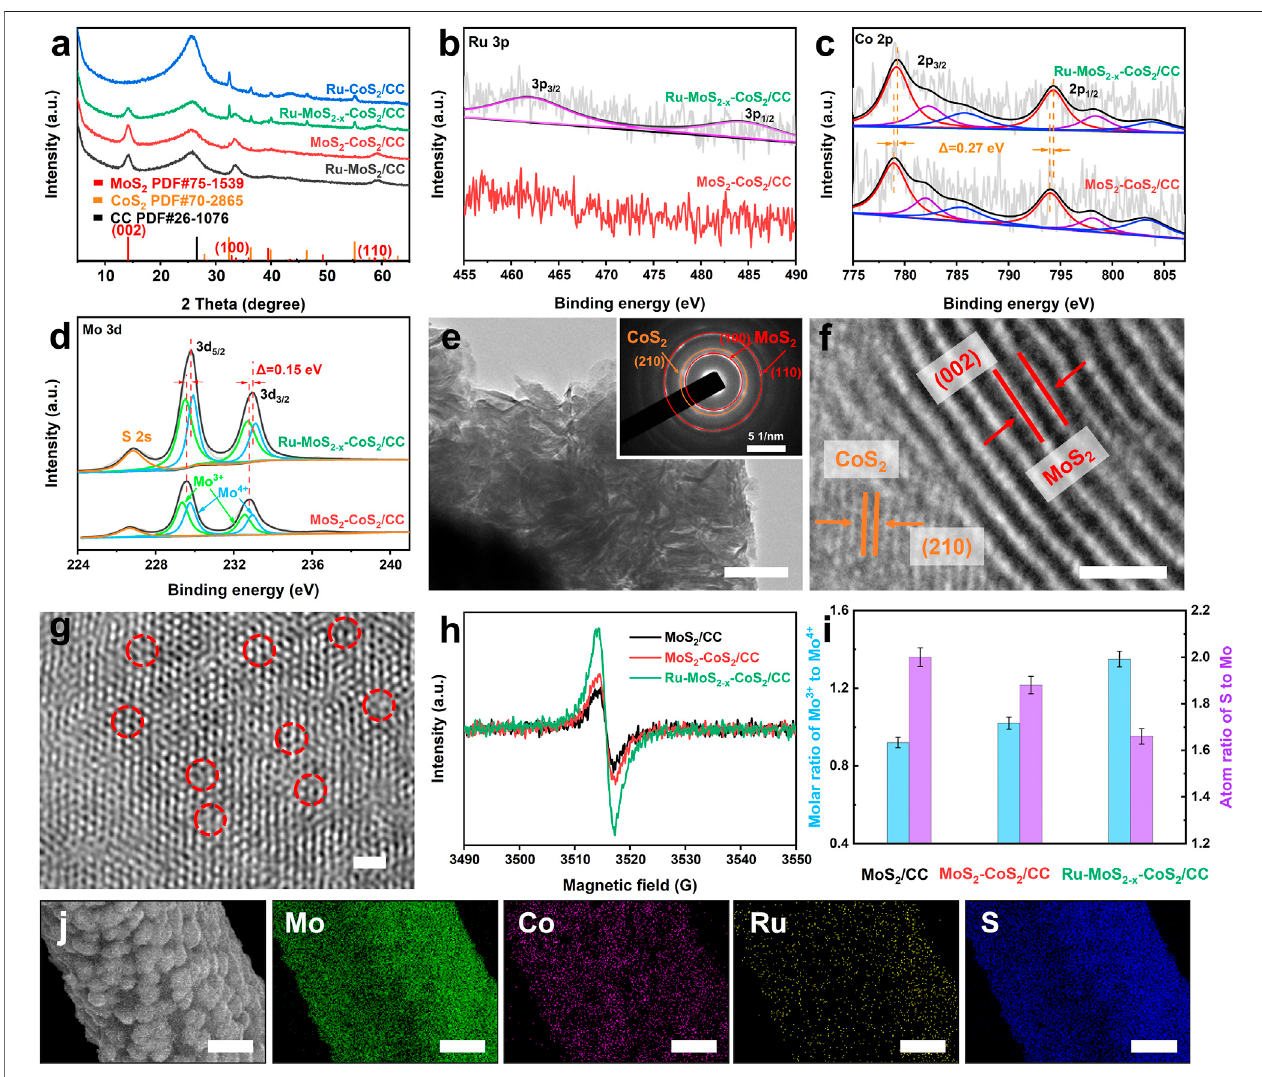
FIGURE 2 | (A) XRD patterns of Ru-MoS 2 /CC, MoS 2 -CoS 2 /CC, Ru-CoS 2 /CC, and the typical samples; (B) Ru 3p, (C) Co 2p, and (D) Mo3d high-resolution XPS spectra of the typical samples and MoS 2 -CoS 2 /CC; (E) TEM image and (F,G) HR-TEM images of the typical samples; (H) EPR spectra, and (I) molar ratio of Mo 3+ to Mo 4+ ,andtheatomratioofStoMoofMoS 2 /CC,MoS 2 -CoS 2 /CC,andthetypicalsamples. (J) EDXmappingpro fi lesofMo,Co,Ru,andSoverthetypical samples.The inset of panel (E) is the SAED pattern of the typical samples. Scale bars of panels (E) , (F) , (G) , and (J) are 100 nm, 2 nm, 2 nm, and 2 μ m, respectively.